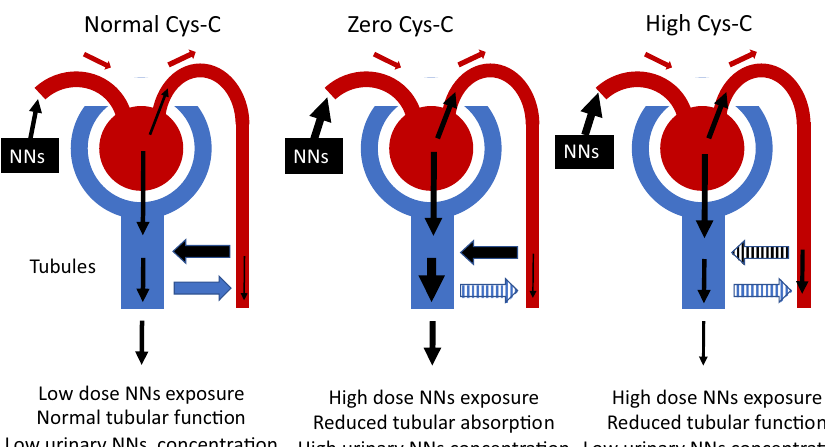
Figure 2. Candidate mechanism of lower urinary neonicotinoids (NNs) concentration in higher urinary Cystatin-C participants and in very low urinary Cystatin-C participants. This figure was originally made by Kumiko Taira with Power Point, following the software’s attribution